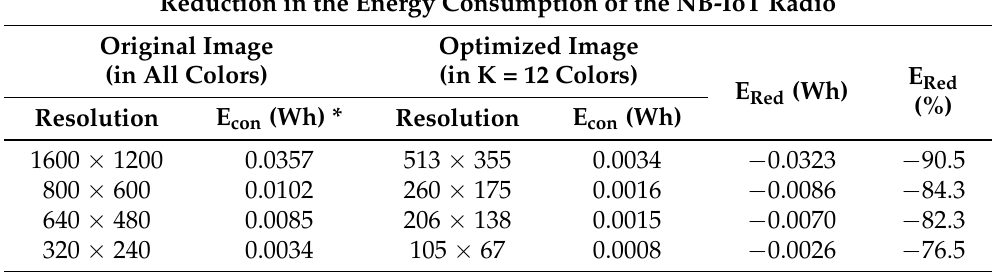
Table 9. The reduced energy consumption for transmitting an optimized image with K = 12 colors in contrast to transmitting an original image with K = all colors.